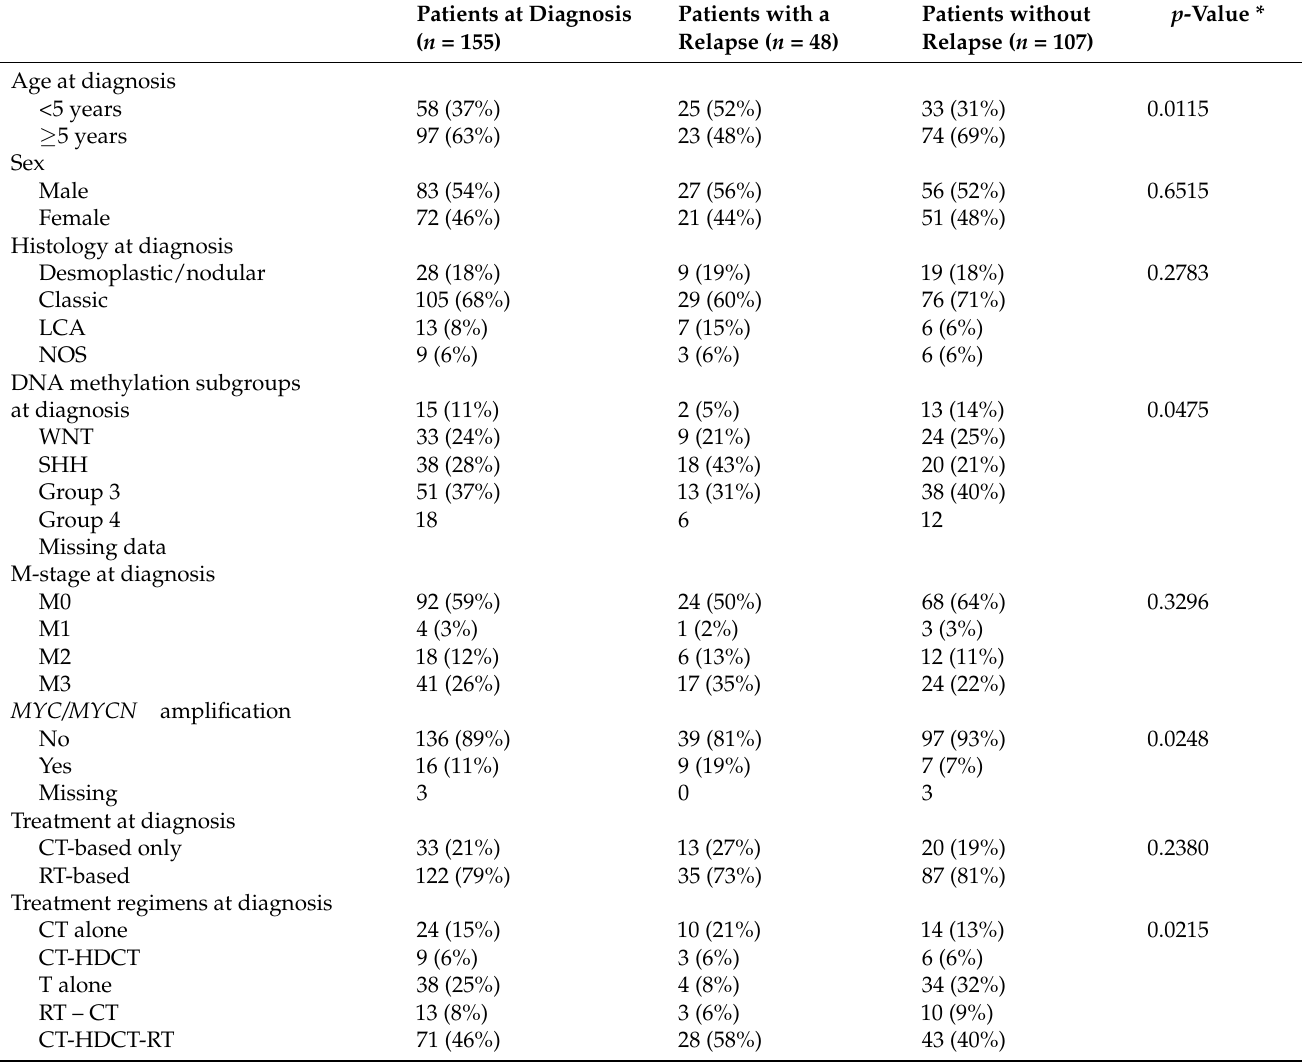
Table 1. Clinical characteristics at diagnosis and